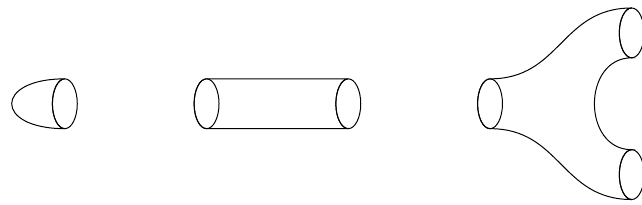
Figure 1 . The disk (left), the cylinder (center) and the pair of pants (right), homeomorphic to the complex plane with respectively zero, one or two holes.